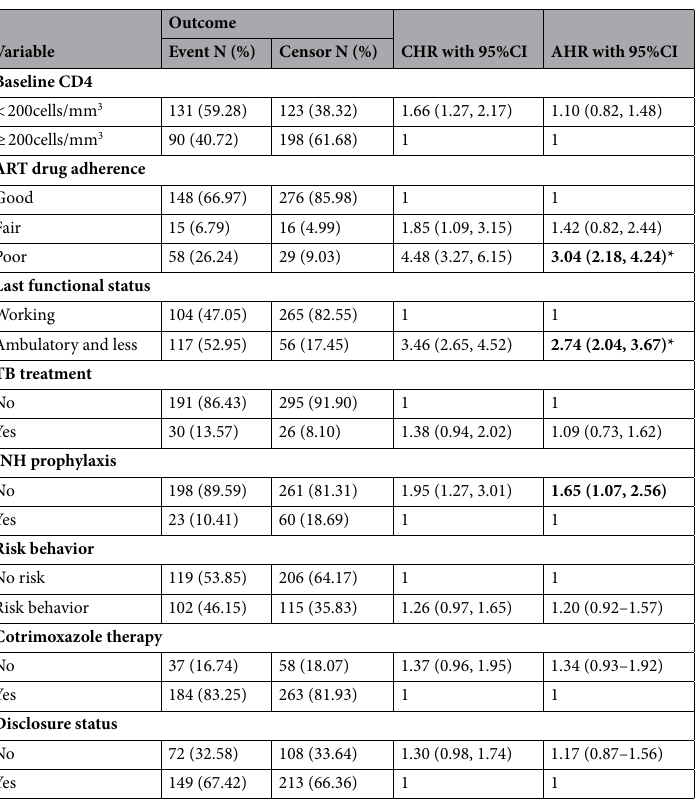
Table 4. Bi-variable and multi-variable analysis of time to lost to follow up and its predators among adult HIV patients in Bichena health center, Amhara, North West, Ethiopia, January 1, 2008–December 30, 2017. *p <